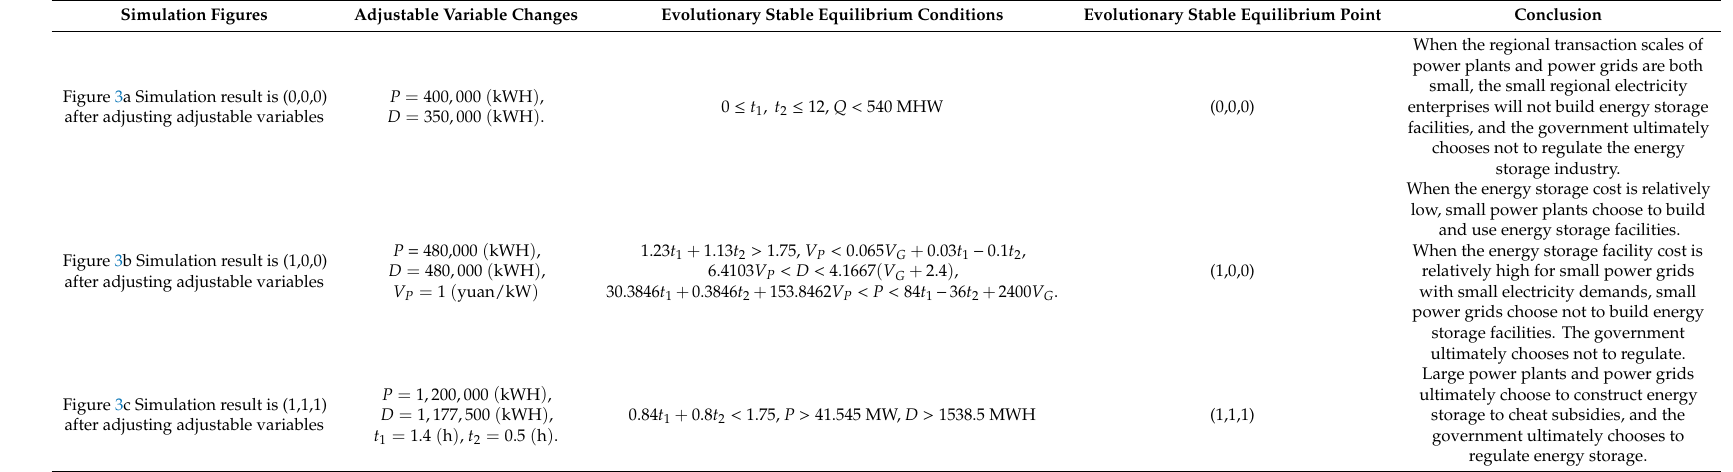
Table 8. Typical examples are given to illustrate the di ff erent evolutionary stable equilibrium points corresponding to di ff erent adjustable variable assignments. Simulation Figures